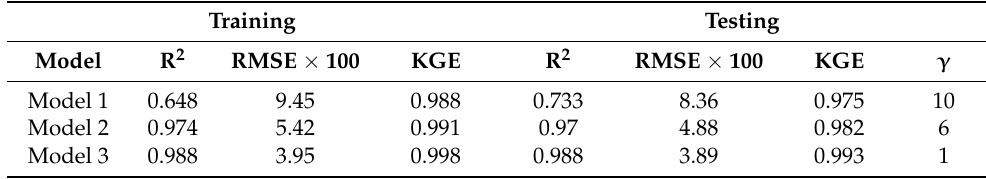
Table 6. The statistical parameters for the SVM model in the second